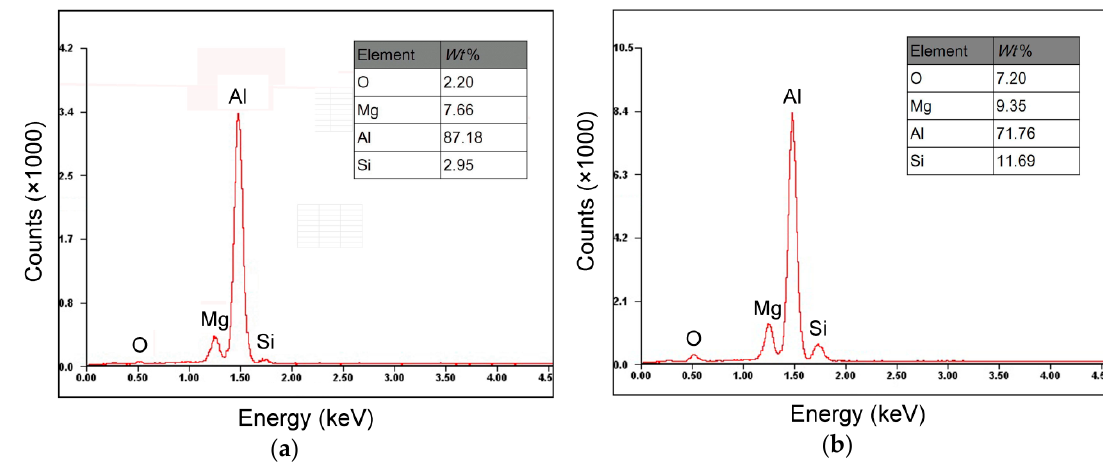
Figure 8. EDS analysis for the superplastic fracture surface of the substrate ( a ) and the filaments ( b ) of the fine-grained 5A70 alloy.